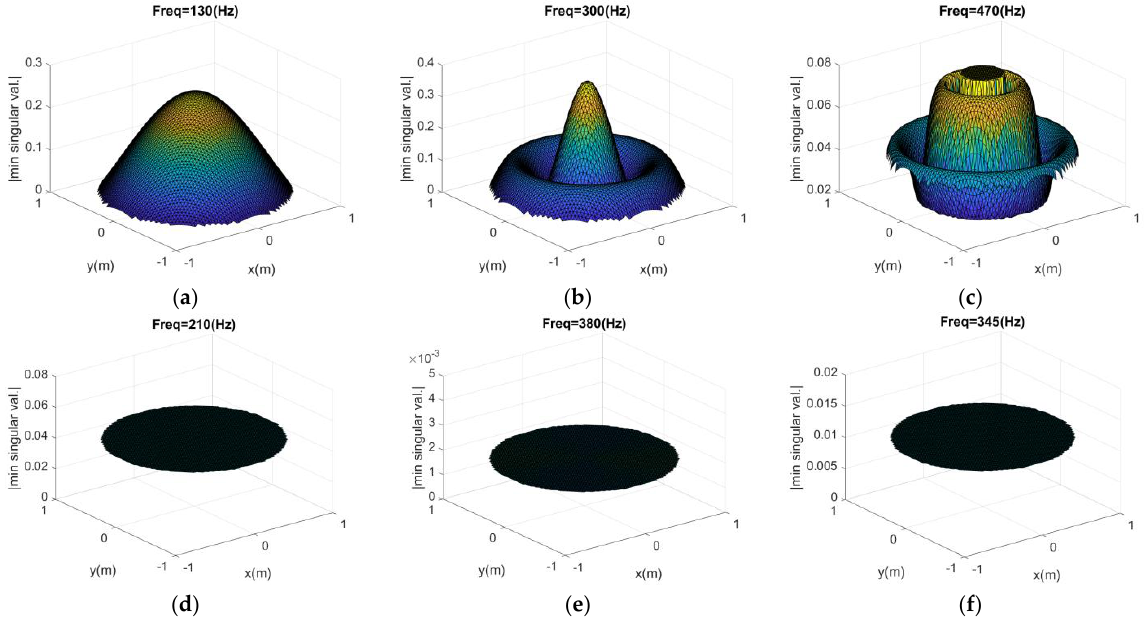
Figure 7. Smallest singular value of the BEM matrix as a function of the position of one CHIEF point: ( a – c ) correspond to frequencies where simultaneously an error peak in the BEM model and a minimum in the singular value curve occur (see Figure 4a); ( d – f ) correspond to frequencies where no error peak occurs in the BEM model, but a minimum in the singular value curve